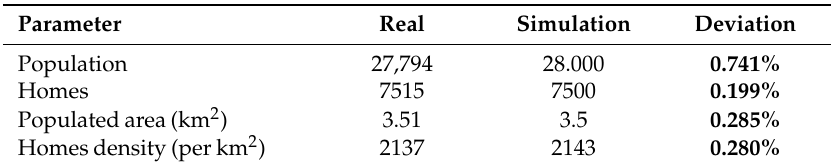
Table 1. Deviation between real data and simplified model.